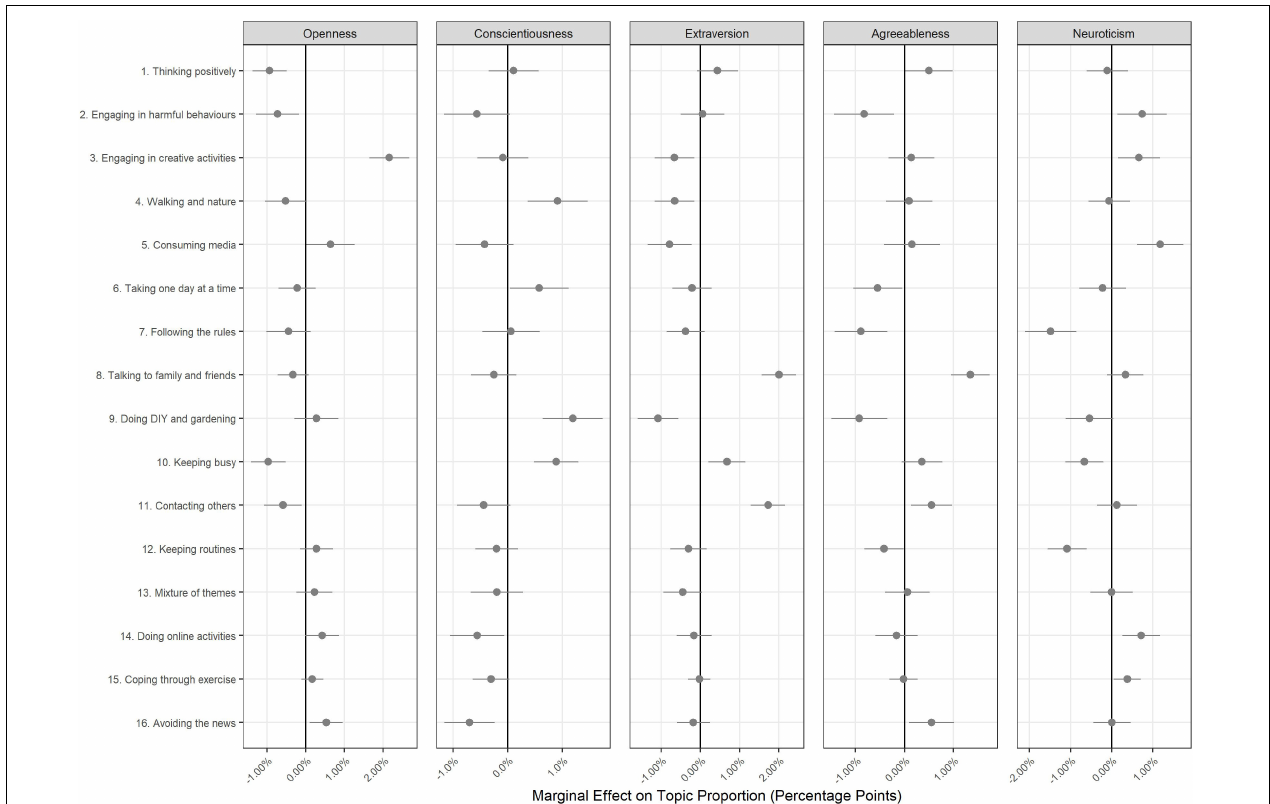
FIGURE 3 | Association between document topic proportion and participant’s Big-5 personality traits (+95% confidence intervals). Results displayed as marginal effects (difference in topic proportion according to change in independent variable). Continuous independent variables are standardized such that a one unit change is equal to a 2 SD difference (Gelman, 2008), Derived from OLS regression models including adjustment for gender, ethnicity, age, education level, living arrangement, psychiatric diagnosis, long-term physical health conditions, self-isolation status, Big-5 personality traits and keyworker